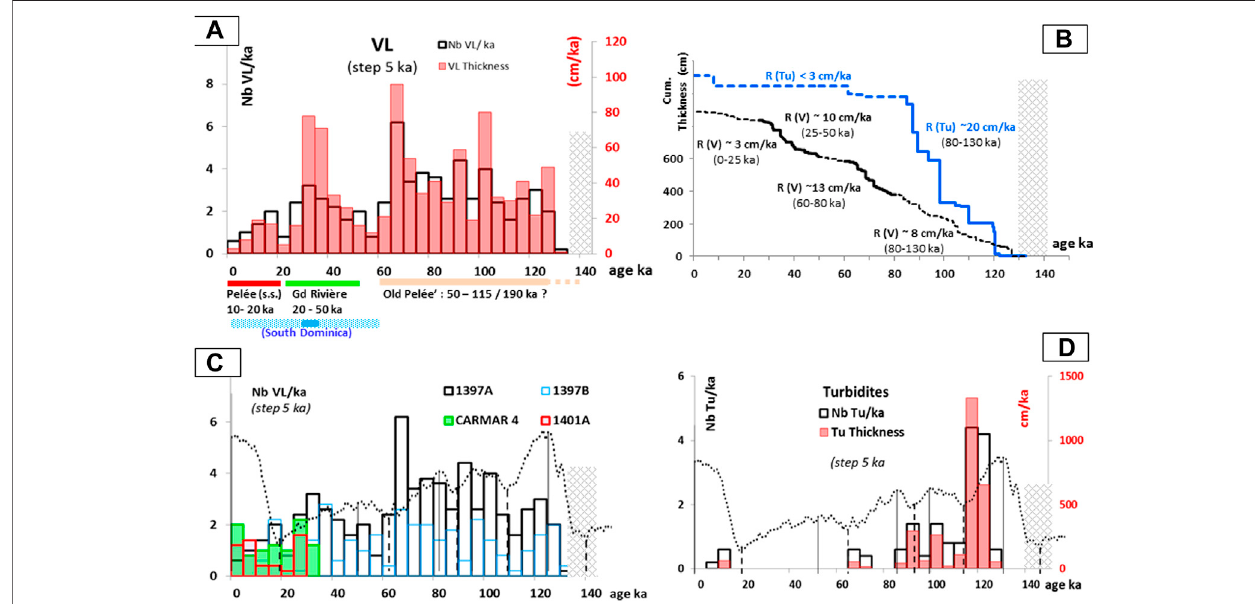
FIGURE 11 | Volcanic tephra deposition rates over the period 0 – 140 ka (core U1397A). (A) Tephra deposition rates. Nb VL/ka: total number of tephra layers (VL) per ka; VL thickness: total thickness of tephra layers per ka. Histograms are drawn with intervals of 5 ka. (B) Cumulative thicknesses of tephra and turbidites. R(V) and R(Tu): deposition rates of tephra and turbidites, respectively, in centimeter per ka. In brackets: intervals of time for each deposition rate estimated using a least square regression. (C) Comparison of tephra deposition rate estimates in cores U1397A, U1401A, and CARMAR-4. Caption as in (A) . Dotted lines: LR04 curves for comparison of deposition rates variations with high and lowstands of the sea level. (D) Deposition rates of turbidites. Caption as in (A) . Dashed zones: sediment gaps. Dotted lines: LR04 curves for comparison of deposition rates variations with high and lowstands of the sea level.